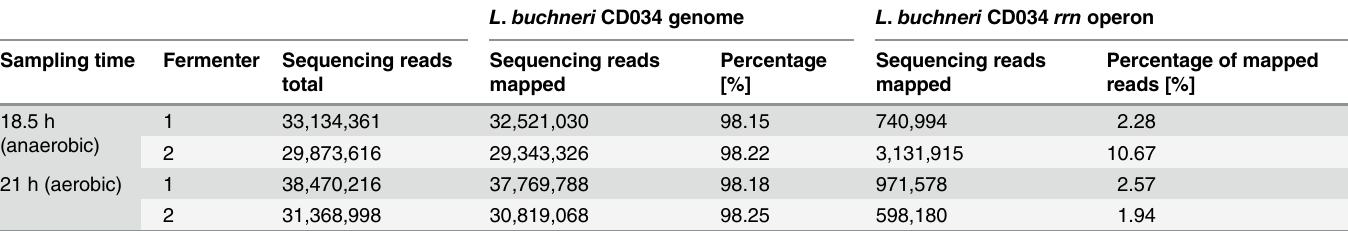
Table 1. Overview on the sequencing of transcripts (mRNA) isolated from L . buchneri CD034 grown in two replicate fermenter systems under anaerobic vs . aerobic conditions.